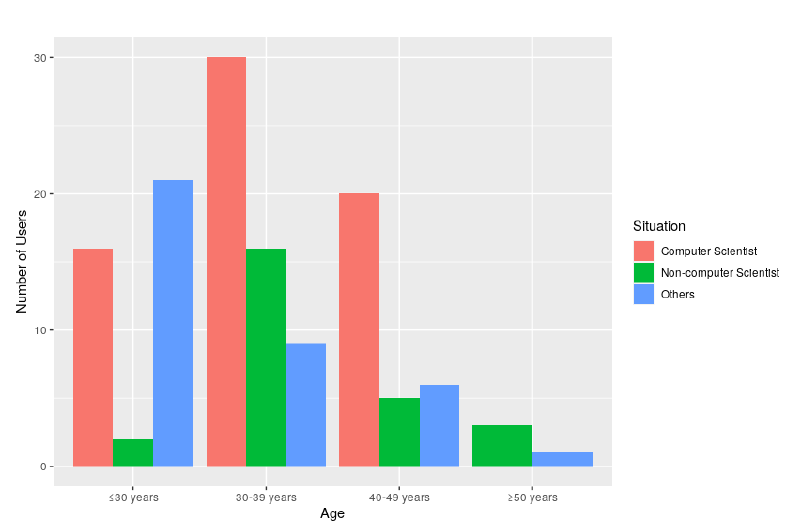
Figure 12. Comparing the job situation versus the age ranges for users who tested the LoT@UNED